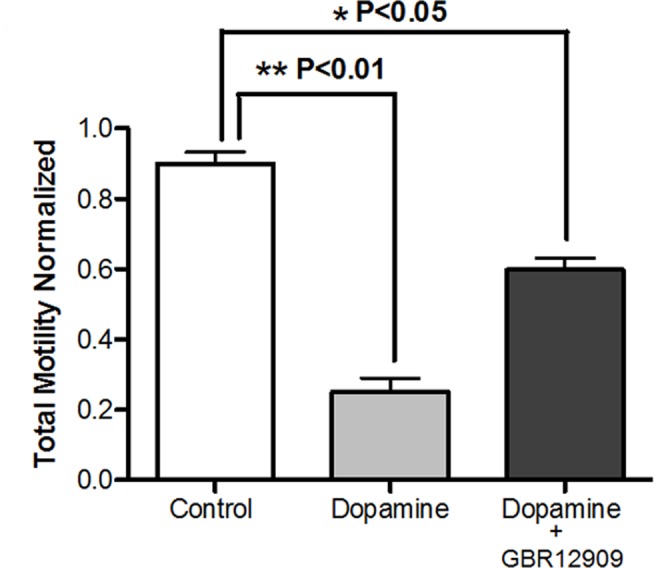
Dopamine transporter inactivation attenuates the inhibitory effect of 1 mM dopamine on total sperm motility.Equine sperm were incubated at 37°C with 1 mM dopamine, with and without the specific DAT inhibitor, 10 µM GBR12909 for 1 hour, in Withenn’s buffer. Total motility was calculated using the CASA system, with a minimum of 500 sperm analyzed per experiment. Total motility was normalized to time zero of the control. Results are the mean ± SEM of four independent experiments. The different letters show significant changes between each treatment with p<0.01. We have considered in each experiment a control to normalize the results to the basal sperm condition before the incubation with dopamine and its respective vehicle.